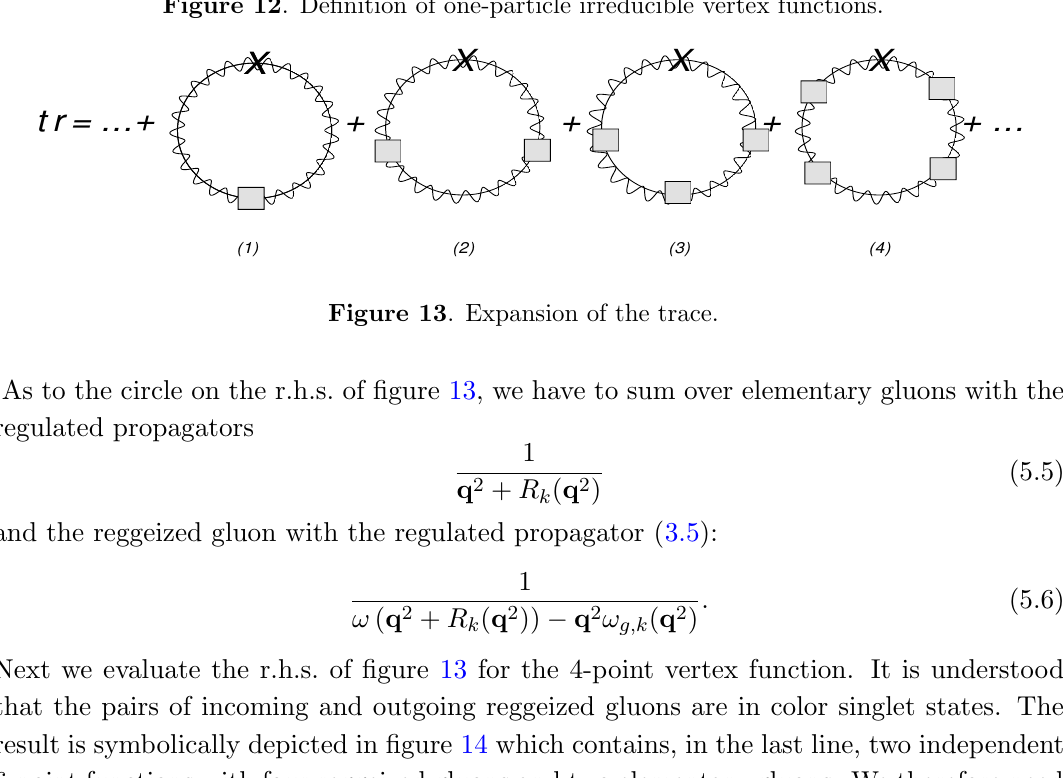
Figure 12 . De(cid:12)nition of one-particle irreducible vertex functions.